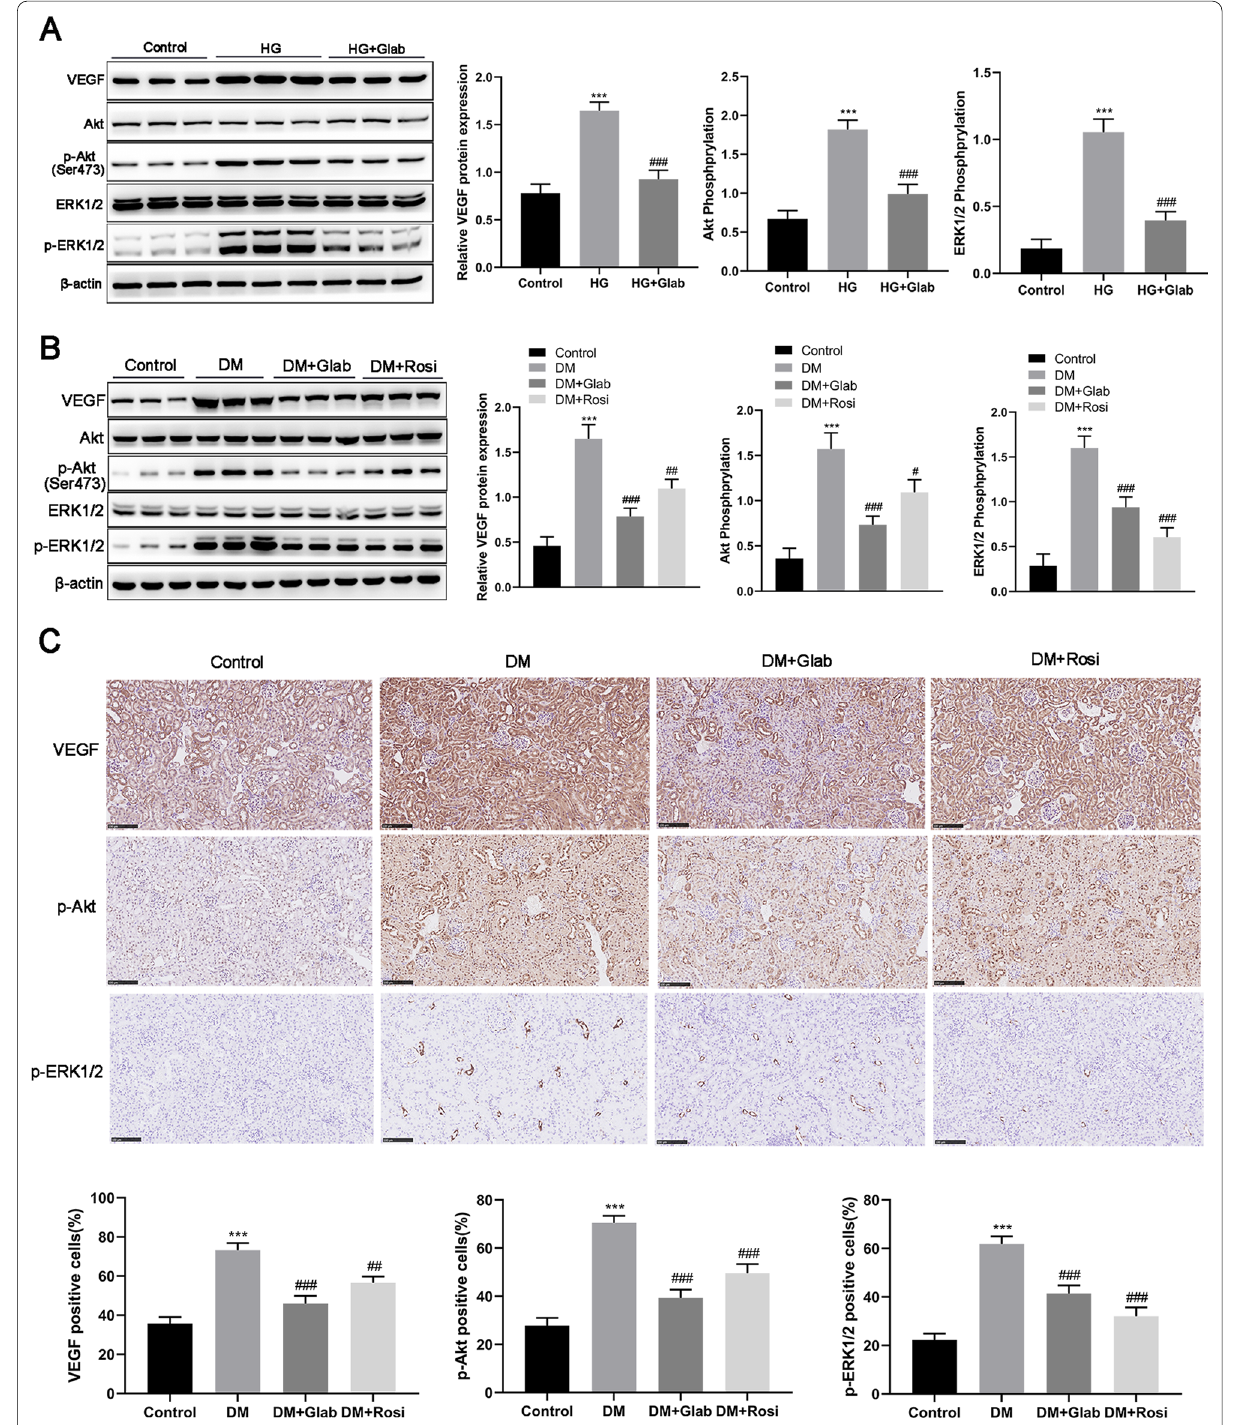
Fig. 7 Effects of Glab on the VEGF/Akt/ERK pathway in DN in vitro and in vivo. Western blot was conducted to analyze the protein expression of VEGF, Akt, p-Akt, ERK1/2, and p-ERK1/2 in ( A ) HG-induced NRK-52E cells and ( B ) the kidney of DM rats. C Representative images and quantitation of immunohistochemistry for VEGF, p-Akt, and p-ERK1/2 in kidney tissues from rats of diverse groups ( *** P < 0.005, vs. the control group; # P < 0.05, ## P < 0.01, and ### P < 0.005, vs. the DM group or the HG